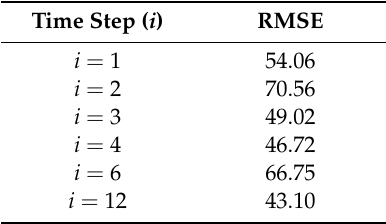
Table 2. The root mean square error (RMSE) validation set for a different number of time steps in the LSTM model.